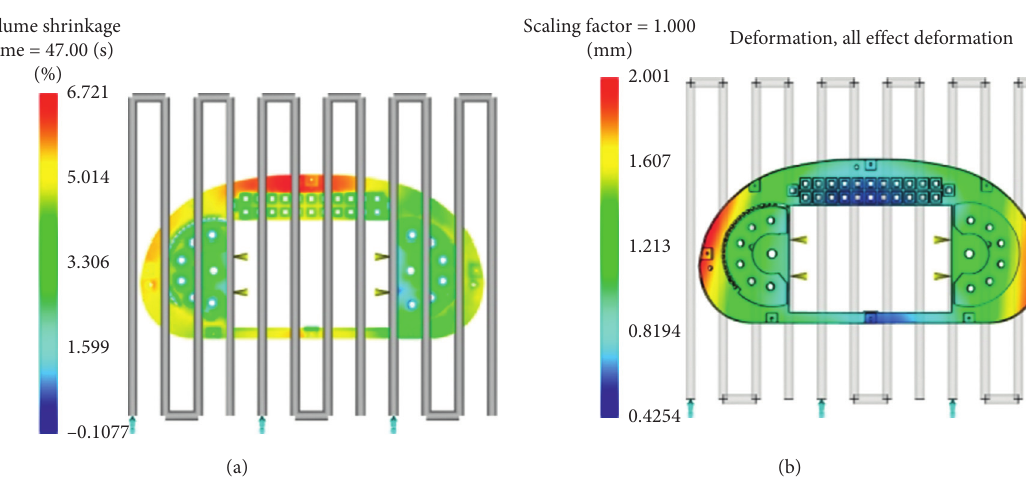
Figure 10: Analysis results for A 1 B 1 C 2 D 4 E 4